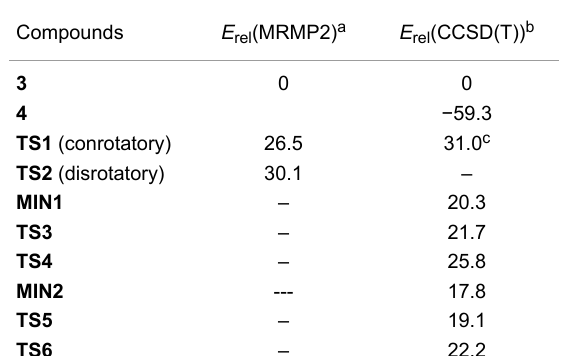
Table 1: Relative energies ( E rel , in kcal mol − 1 including zero-point vibrational energies, ZPVE) of 1,2-dihydro-1,2-azaborine ( 4 ), its Dewar valence isomer 3 , high energy minima, and the transition states for ring opening of 3 as computed at the MRMP2 and CCSD(T) levels of